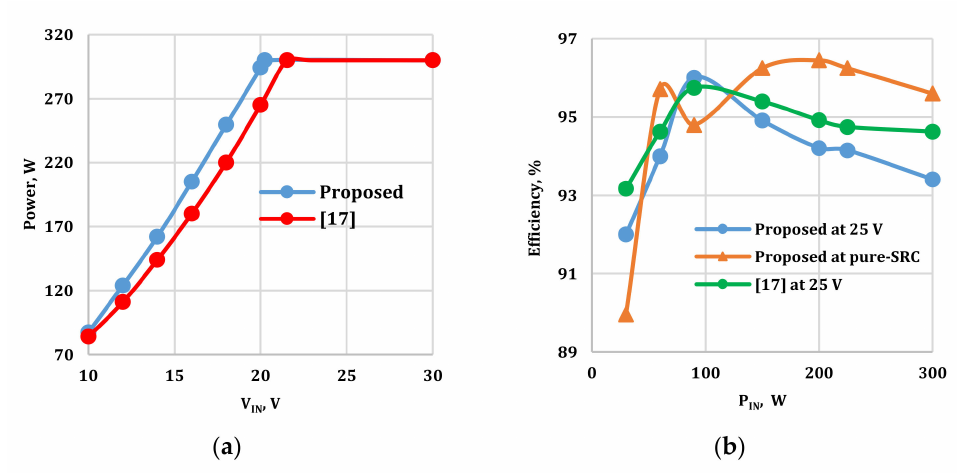
Figure 15. Comparison between the proposed topology and the topology in [17]: ( a ) Measured operating range and ( b ) measured